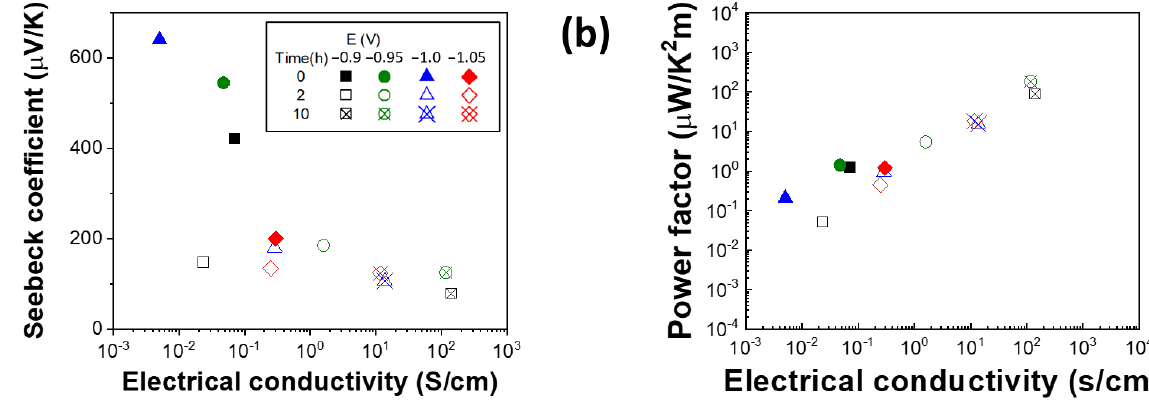
Figure 6. Seebeck coefficient ( a ) and power factor (PF) ( b ) of as-deposited and annealed PbTe films at 200 °C for 2 and 10 h as a function of electrical conductivity.